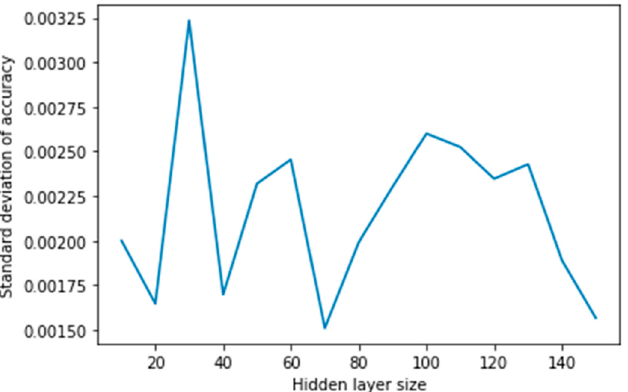
Figure 8. Standard deviation of accuracy depending on the number of neurons in the hidden layer for the random clicker classifier.